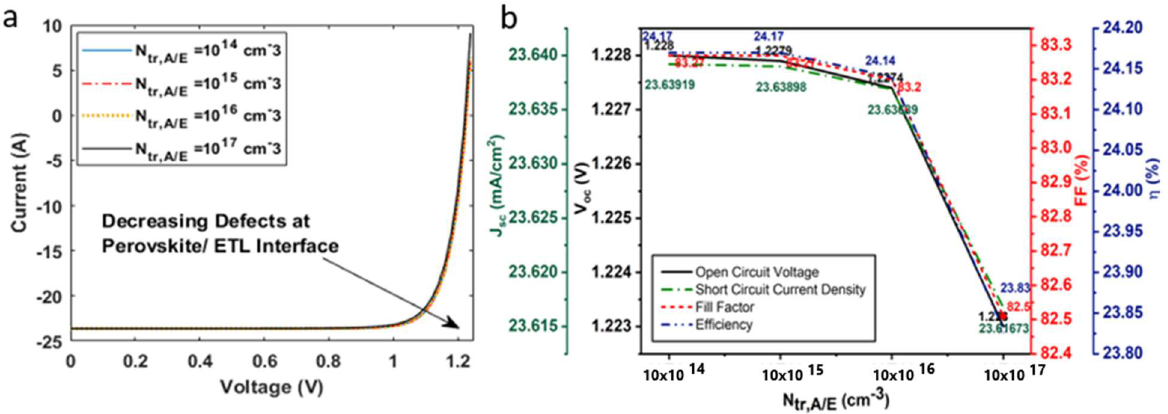
Figure 11. ( a ) Current voltage characteristics of solar on inclusion of interface defects at hole transport layer/absorber layer; ( b ) influence of interface defects on open-circuit voltage, short-circuit current density, fill factor, and efficiency of the solar cell.